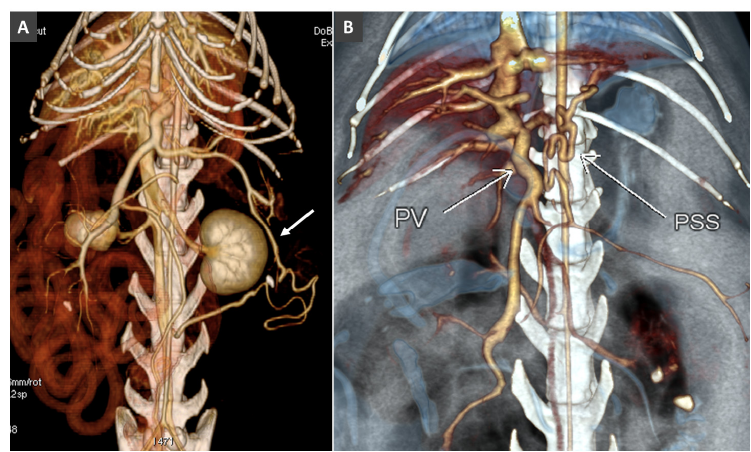
Figure 18. A . Dorsal thin-MIP showing small varices in left retroperitoneal region (gastrophrenic varices) and splenogonadal shunt in a dog with portal hypertension. B . Transverse view at the diaphragmatic level in a dog with portal hypertension and oesophageal varices. C . Transverse view of the cranial abdomen in a dog with portal hypertension due to HAVM. Arrow indicates gastric submucosal varices. Ao, aorta; CdVC, caudal vena cava; PV, portal vein; crMV, cranial mesenteric vein.